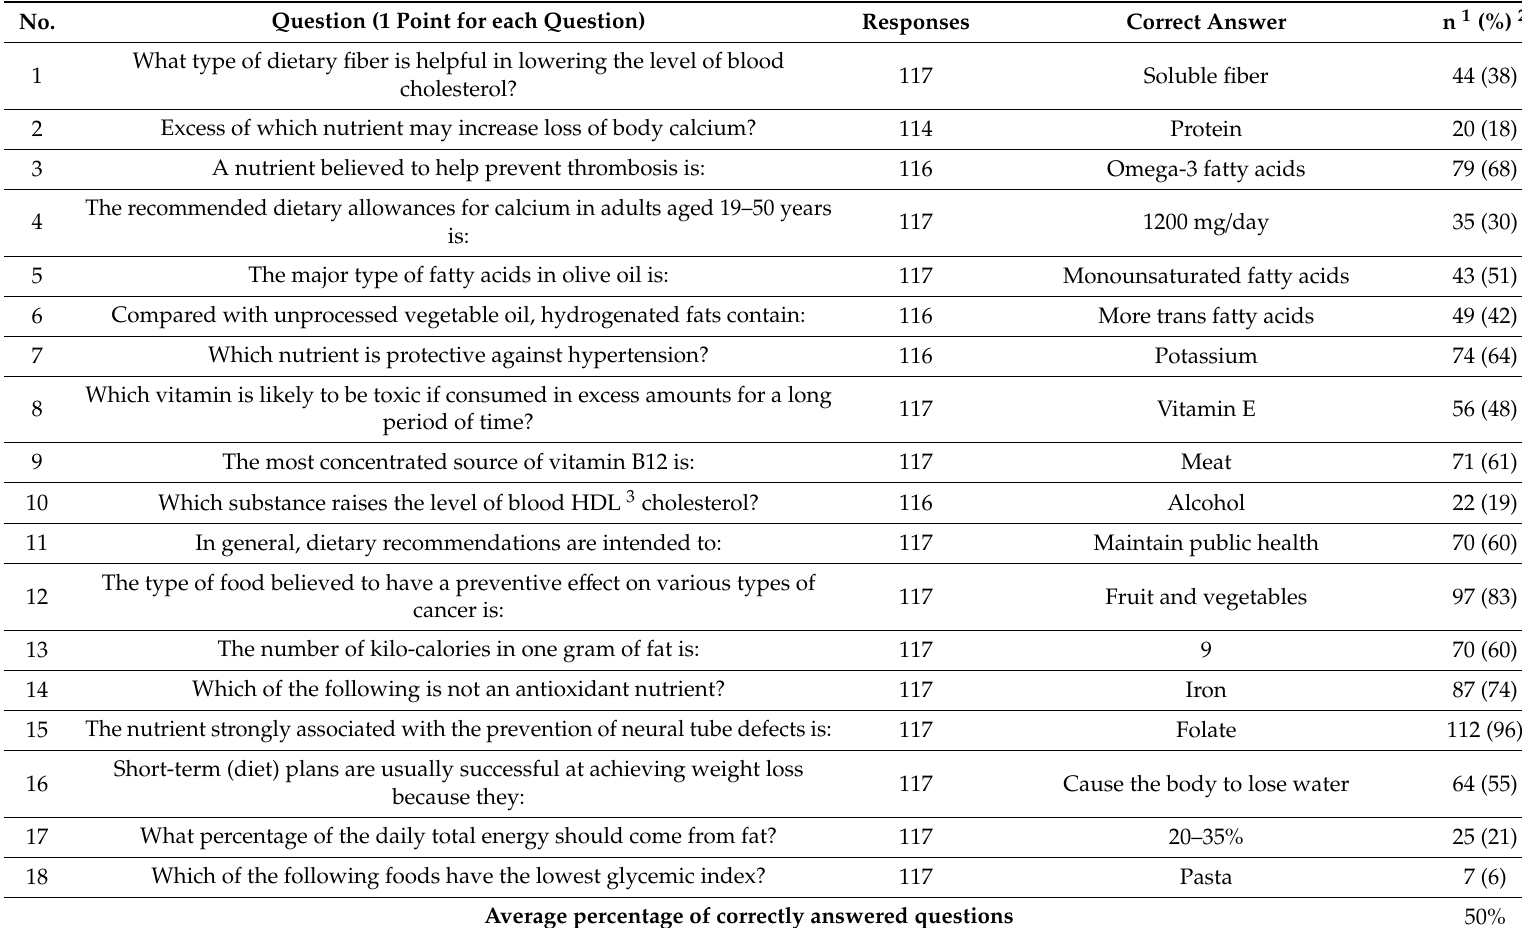
Table 2. Number and percentage of correct answers to the nutritional knowledge questions among Saudi